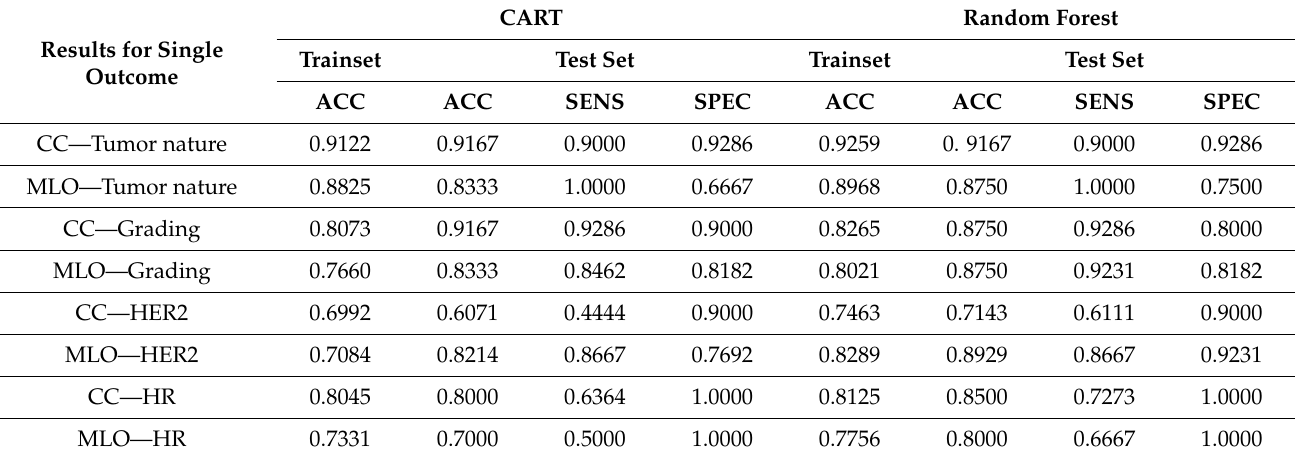
Table 4. Results for CART and RF